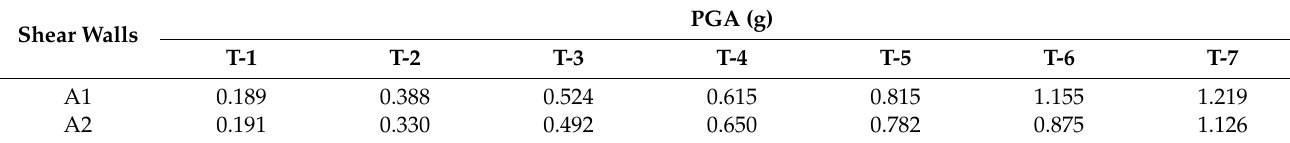
Table 3. Test procedure